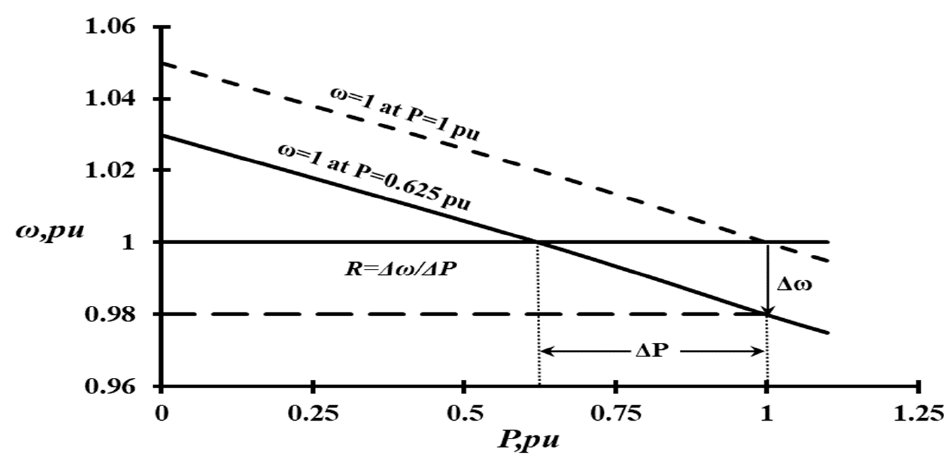
Figure 4. The block-diagram of a PSN based on LFC [30].